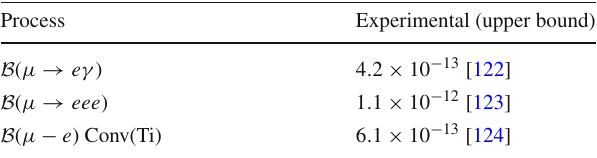
Table 2 Experimental upper bound for the branching fraction of lep- tonic flavour observables in the 1-2 sector Process Experimental (upper